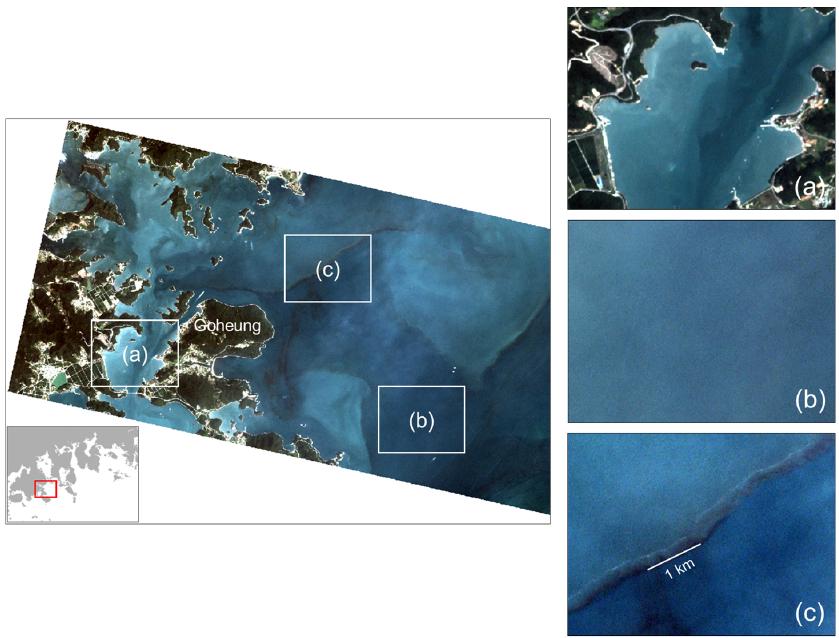
Figure 4. 3B surface reflectance (SR) PlanetScope true-color composite image (R: 630 nm; G: 545 nm, B: 485 nm) acquired near the coast of Goheung on 29 July 2018 at 01:42 GMT. Selected regions, ( a – c ) in the left image are enlarged on the right panels. Regions ( a – c ) represent turbid, the surrounding, and red tide waters, respectively. Region ( c ) shows a high-density M. polykrikoides strip in brown appearing along the coast of Goheung (2500 cells mL − 1 ).